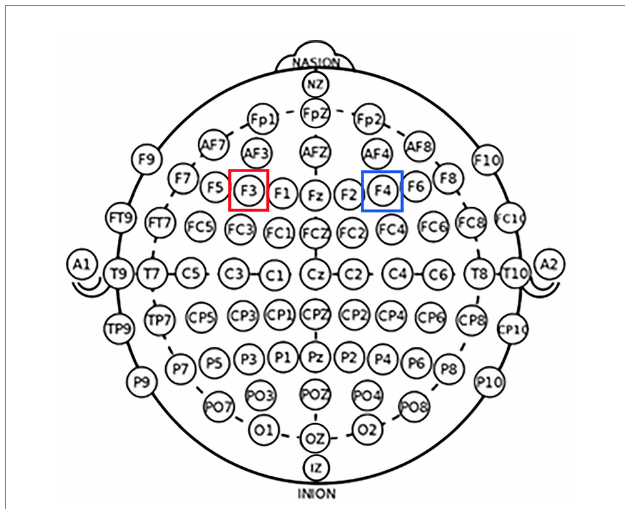
FIGURE 1 Schematic and electrode locations of DLPFC. Schematic of the electrode positions F3 and F4 based on the international EEG 10–20 system.